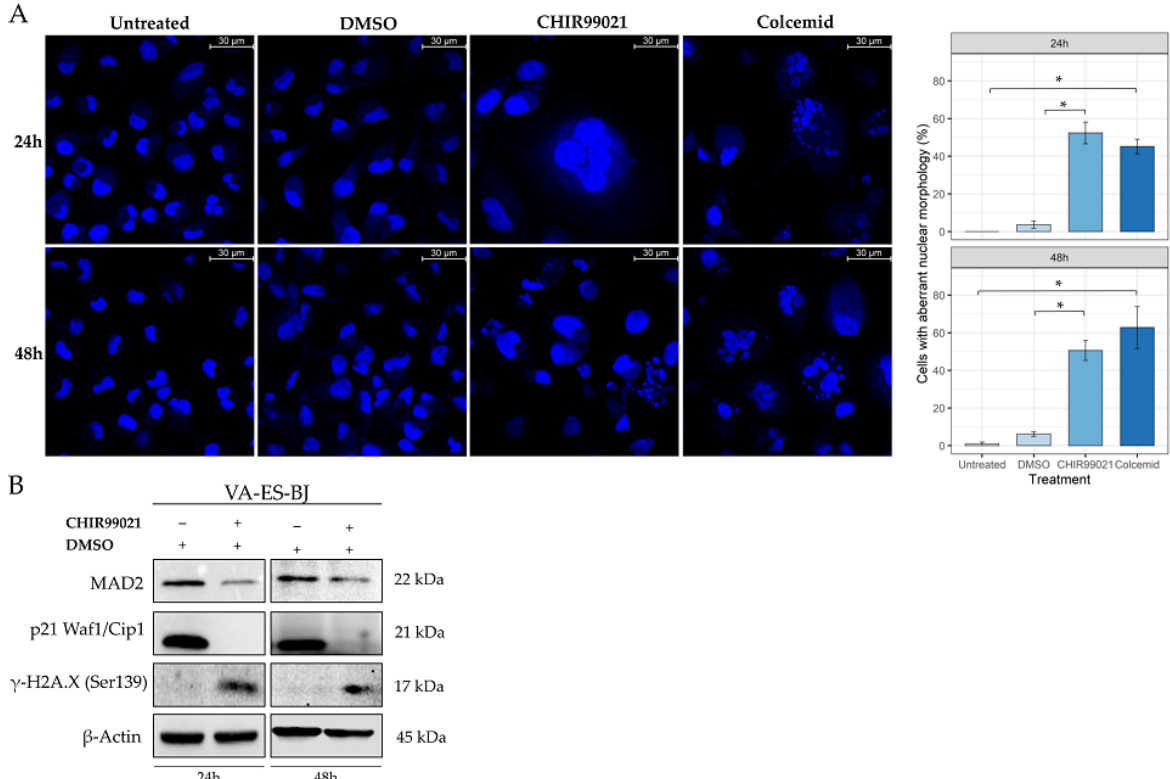
Figure 5. CHIR99021 induces mitotic catastrophe in the ES cell line. ( A ) Cells were treated with CHIR99021 100 µ M for 24 or 48 h, stained with Hoechst-33342, and examined under fluorescence microscopy at 63X magnification. As shown, many cells have characteristics peculiar of mitotic catastrophe. The aberrant morphology of cells was based on the evaluation of at least 30 nuclei in each sample. Each bar is the mean ± S.E. of three separate experiments; * p < 0.05, versus the relative control. ( B ) Western blot analysis reported the expression levels of protein related to mitotic or spindle checkpoint arrest at 24 and 48 h after CHIR99021 100 µ M treatment on VA–ES–BJ. The blot was first incubated with anti-MAD2, anti-p21 Waf1/Cip1 and anti- γ -H2A.X and then reprobed with anti- β -Actin to confirm the equal loading of each lane (40 µ g of whole lysate). The same scenario, large cells with multiple micronuclei, resulted also after 48 h of treatment: CHIR99021 (50.6% ± 5.3; p = 0.01) vs. DMSO (6.2% ± 1.3) and Colcemid (62.8% ± 11.1; p = 0.003) vs. untreated (0.9% ± 0.9). No significant difference was